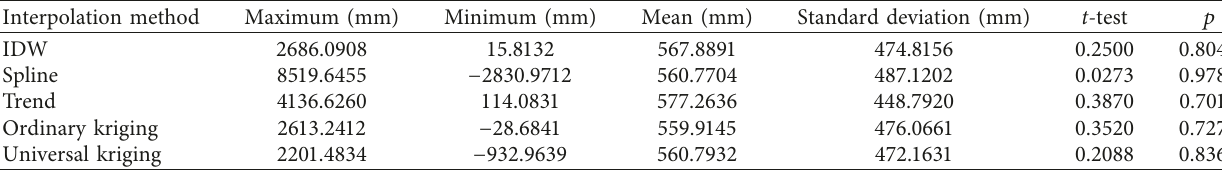
Table 1: Accuracy comparison of the five interpolation methods.